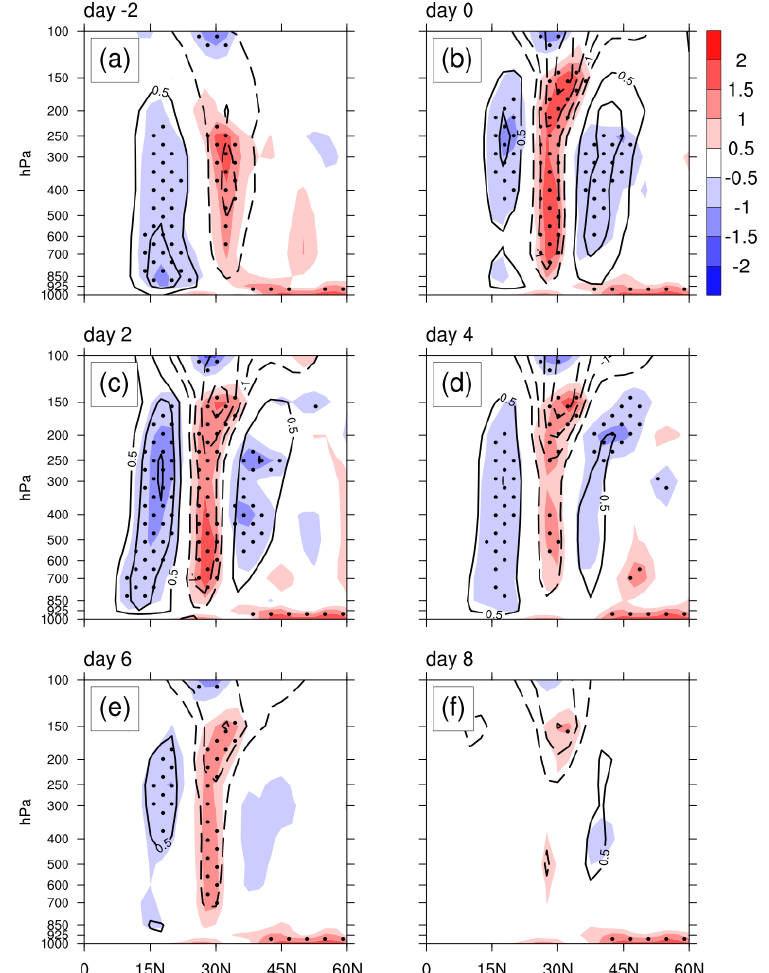
Figure 11. Latitude-pressure cross-section (115–125° E) of vertical p -velocity (contour; units: hPa s −1 ) and significant anomalies of diabatic heating rate (shading; units: K day −1 ) in EAP/SR-C events from day −2 to day 8 with interval of 2 days ( a – f ). The dotted filled shadings denote that the anomalies of diabatic heating rate are statistically significant at the 0.05 level.